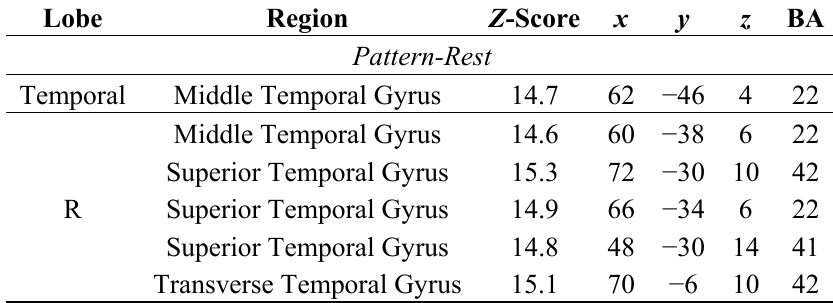
Table 2. Stereotactic MNI coordinates, Z -score values, and anatomical and Brodmann areas for activations during the Pattern condition contrasted to